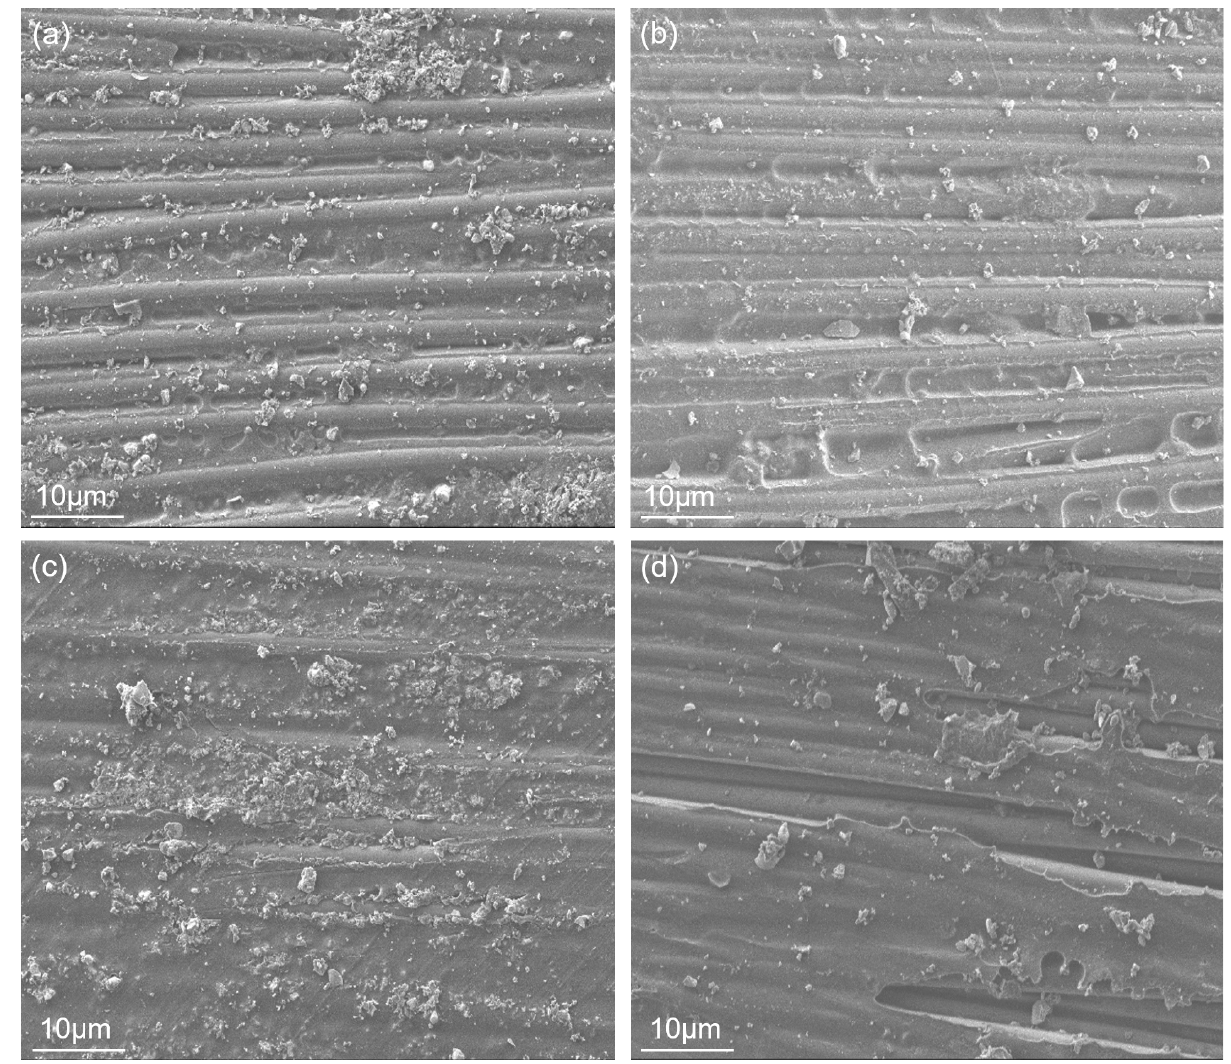
Figure 8: SEM images of composites with 6% nano-silica: sequence I: (a) resin surface, (b) fiber surface and resin film; sequence II: (c) resin surface, (d) fiber